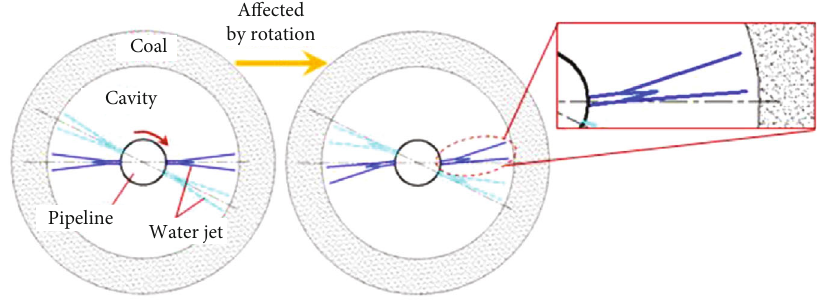
Figure 16: In fl uence of the rotation speed on the shape of HPWJ.